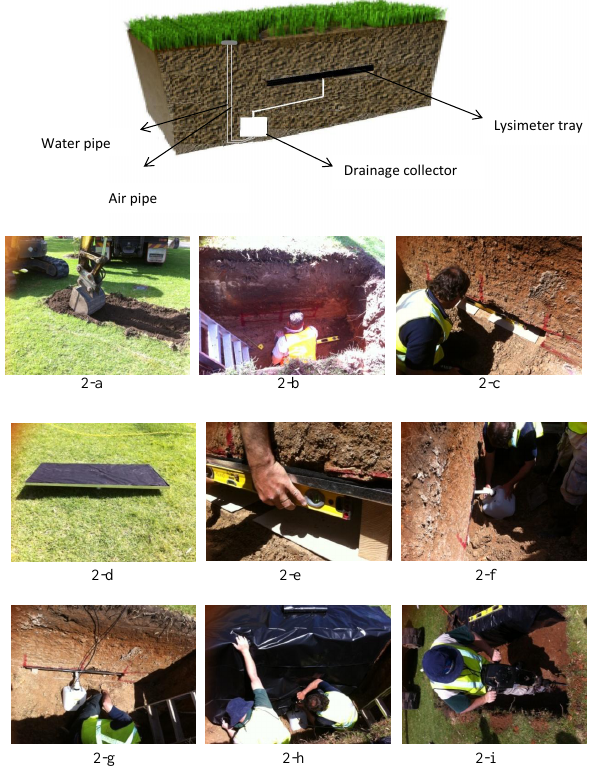
Fig. 2. Pan lysimeter installation, (a) trench excavation, (b) cavity Fig. 2 Pan lysimeter installation, 2-a trench excavation, 2-b cavity digging, 2-c cavity 605 digging, (c) cavity levelling, (d) lysimeter tray, (e) placing the tray, levelling, 2-d lysimeter tray, 2-e placing the tray, 2-f placing the collecting bucket 606 and connect the tray and bucket by a PVC pipe, 2-g PVC pipe and access tubes, 2- 607 (f) placing the collecting bucket and connect the tray and bucket by h plastic sheet for protecting the cavity, 2-i compacting the backfilled soil. 608 a PVC pipe, (g) PVC pipe and access tubes, (h) plastic sheet for 609 protecting the cavity, (i) compacting the backfilled soil.